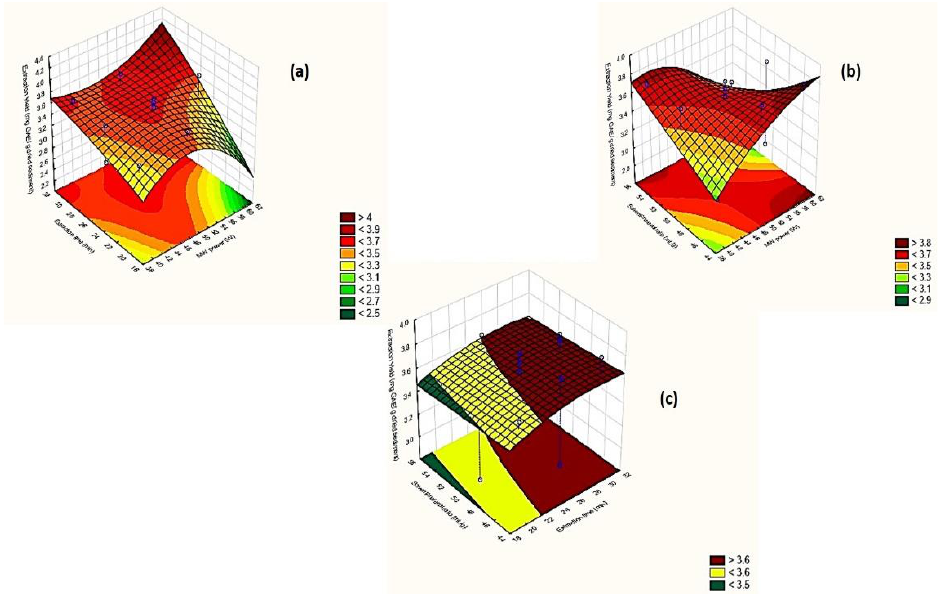
Figure 2. RSM plots of ( a ) extraction time vs MW power; ( b ) solvent/material ratio vs MW power; ( c ) solvent/material ratio vs extraction time.